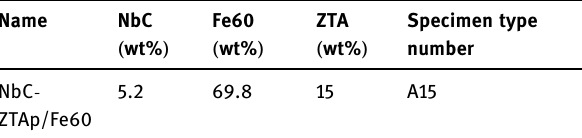
Table 5: Design of sample preparation